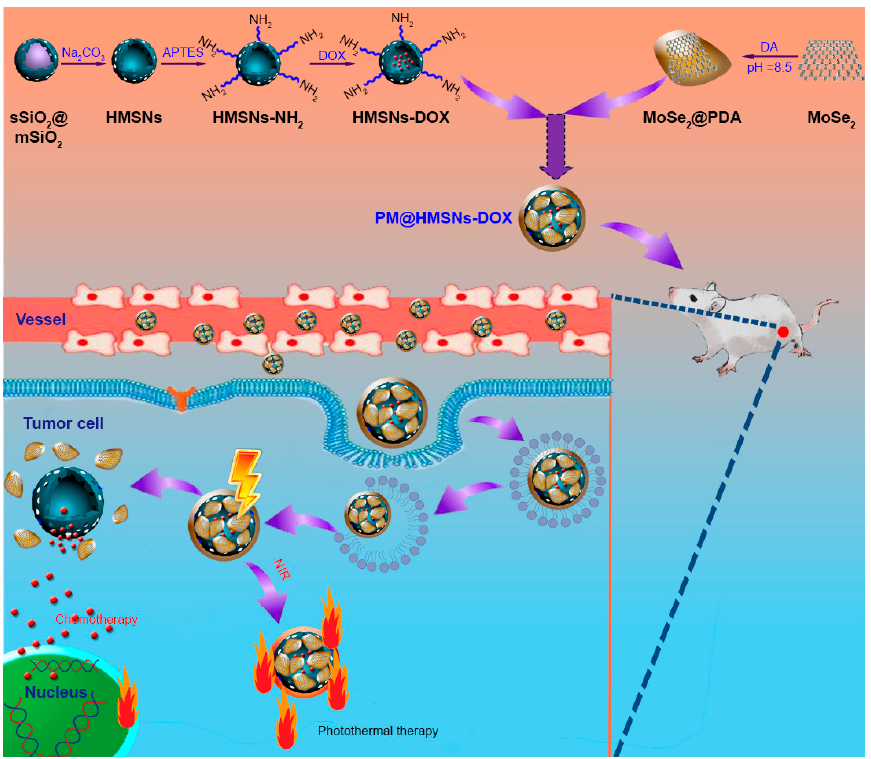
Figure 6. Graphical representation of the preparation of dual sensitive MSNs for pH/NIR-responsive chemo-photothermal therapy [26]. chemo-photothermal therapy